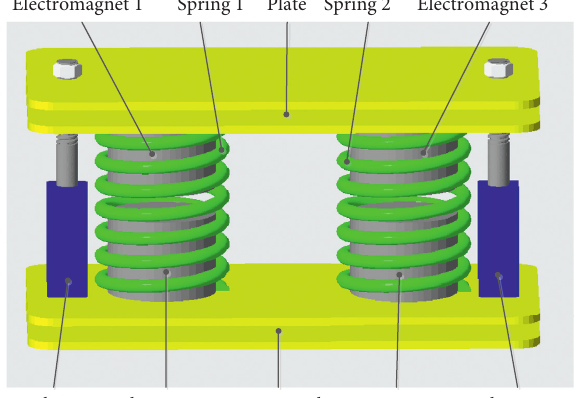
Figure 1: Structure of the electromagnetic isolation